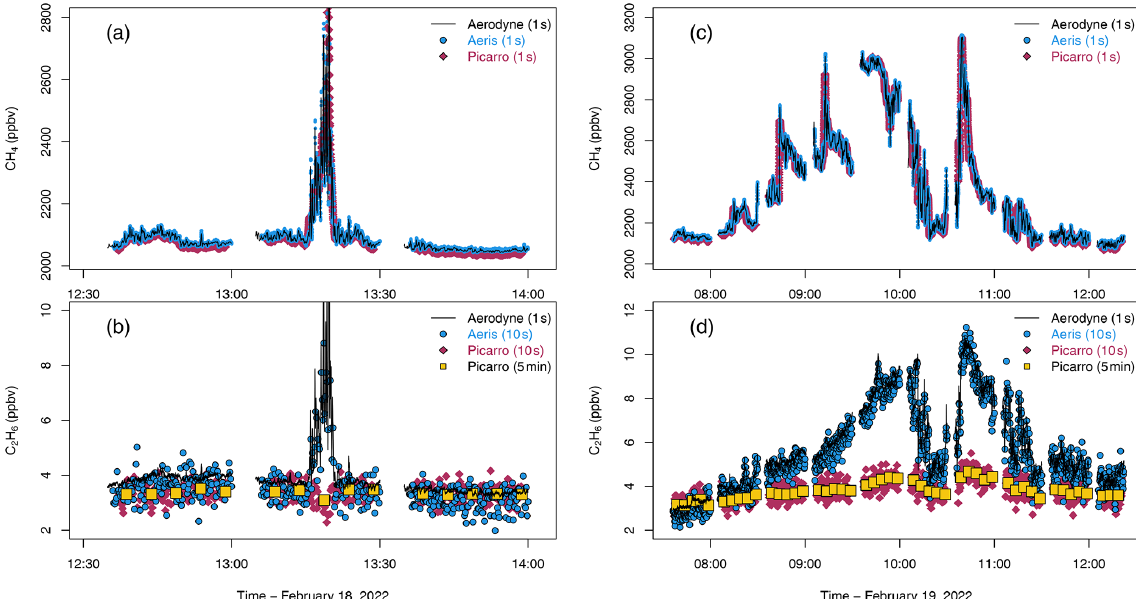
Figure 4. Ambient sampling for methane (ppbv, top row) and ethane (ppbv, bottom row) for (a–b) a short natural gas plume on 18 Febru- ary 2022 and (c–d) a large-scale change in methane and ethane overnight and into the early morning of 19 February 2022. Times in UTC. Aerodyne SuperDUAL (black line), Aeris MIRA (blue circle), Picarro G2210-i (red diamond), and Picarro G2210-i averaged to 5min in yellow square. All instruments were corrected for humidity and calibrated to NOAA calibration